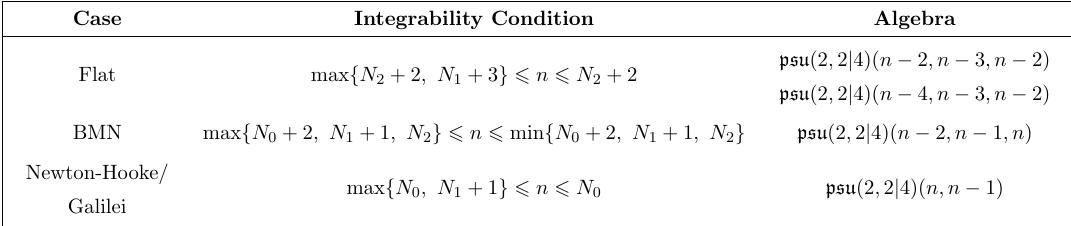
Table 2 . We show, in the di(cid:11)erent cases considered in this work, for an action term at n -th order in the expansion, the conditions that should hold between n and the truncation orders N 0 ; N 1 ; : : : to ensure integrability. In the last column we list the possible truncated algebras ful(cid:12)lling these conditions. It is immediate to see that some truncations are ruled out by the conditions.